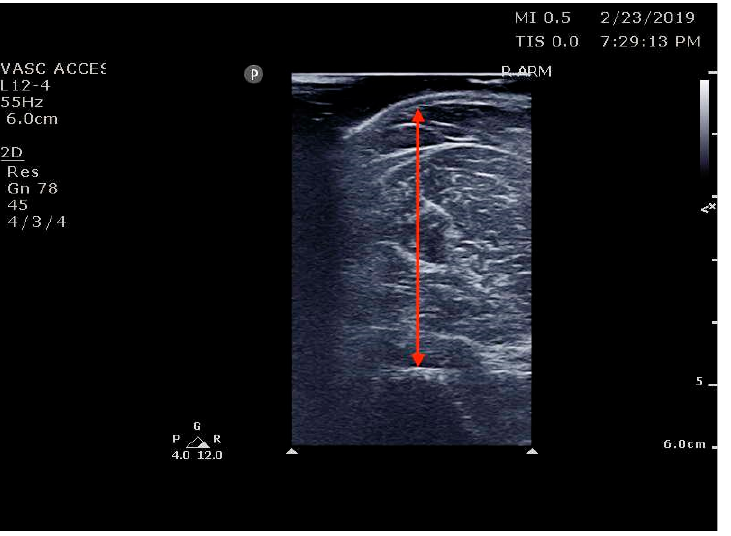
Figure 1 [33] . Bicep brachii thickness measurement. Figure 1. Ref. [33] Bicep brachii thickness